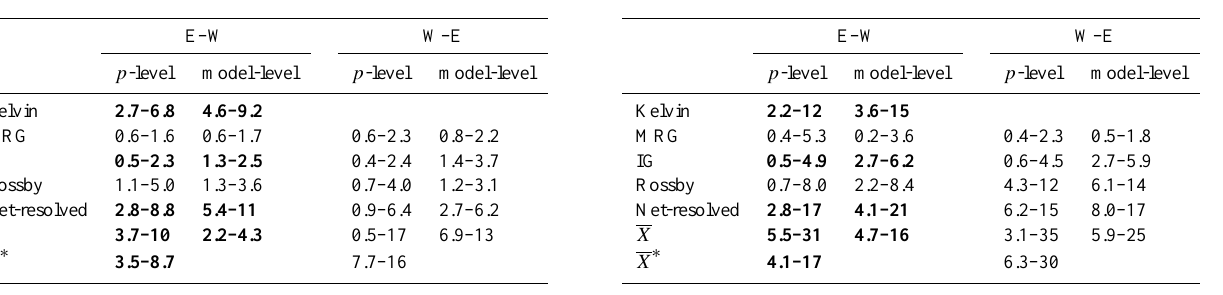
Figure 6. The same as in Fig. 2, except for the terms (a) X , (b) X